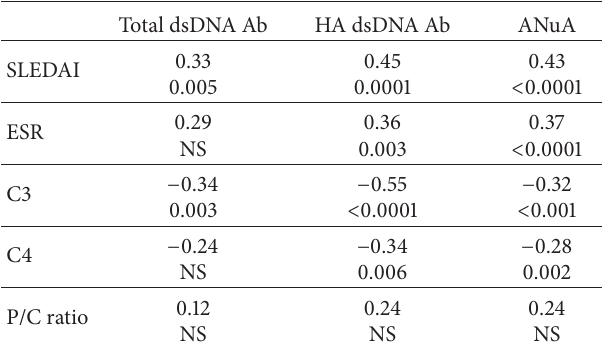
Table 2: Correlation of total dsDNA antibodies, HA dsDNA antibodies, and ANuA with clinical and laboratory findings in SLE patients.